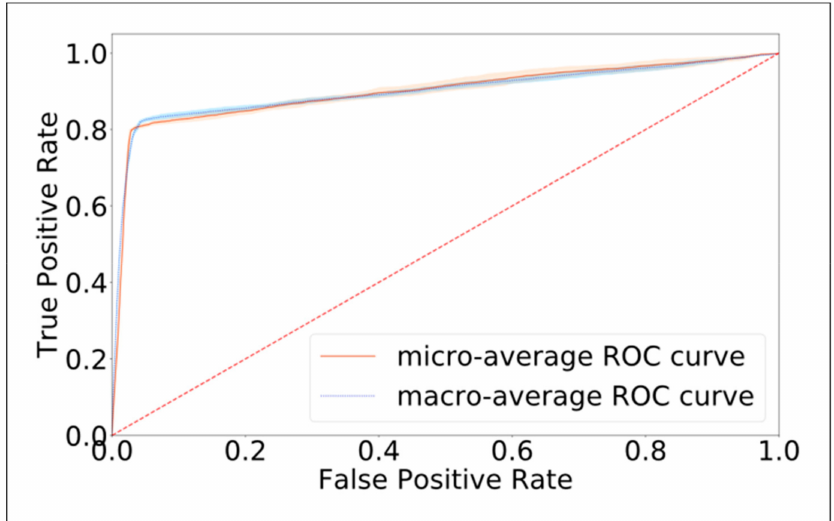
Figure 5. The receiver operating characteristic curve (ROC) of model performance in predicting the canal a ff ected by benign paroxysmal positional vertigo (BPPV) after model training. The macro-average area under the ROC (AUROC) was 0.901 ± 0.008, and the micro-average AUROC was 0.901 ± 0.007, suggesting that our model performed well in identifying which canals were a ff ected in BPPV